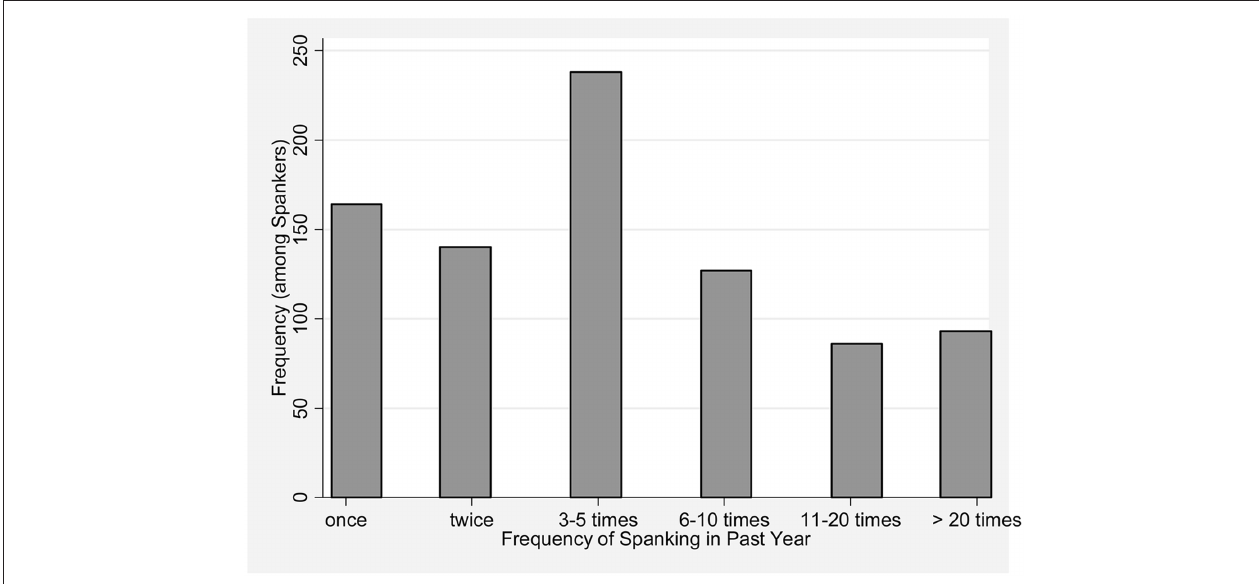
FigUre 1 | spanking frequency among spankers ( N = 875). Note: This figure does not include the 2027 mothers (70%) who reported not spanking in the past